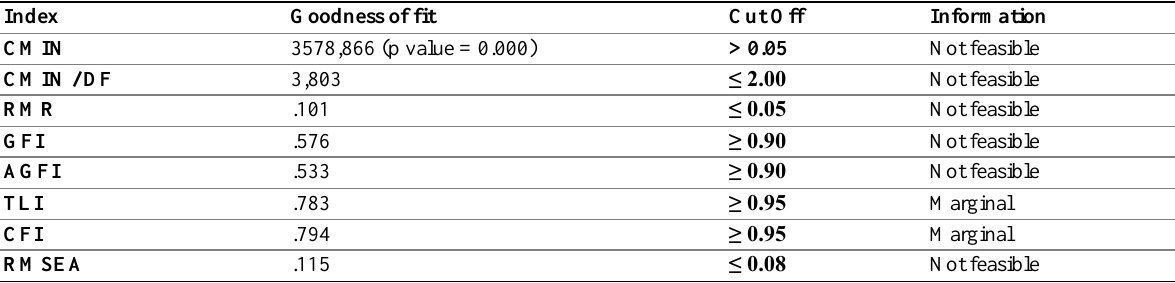
Table 6: Evaluation of Goodness of Fit